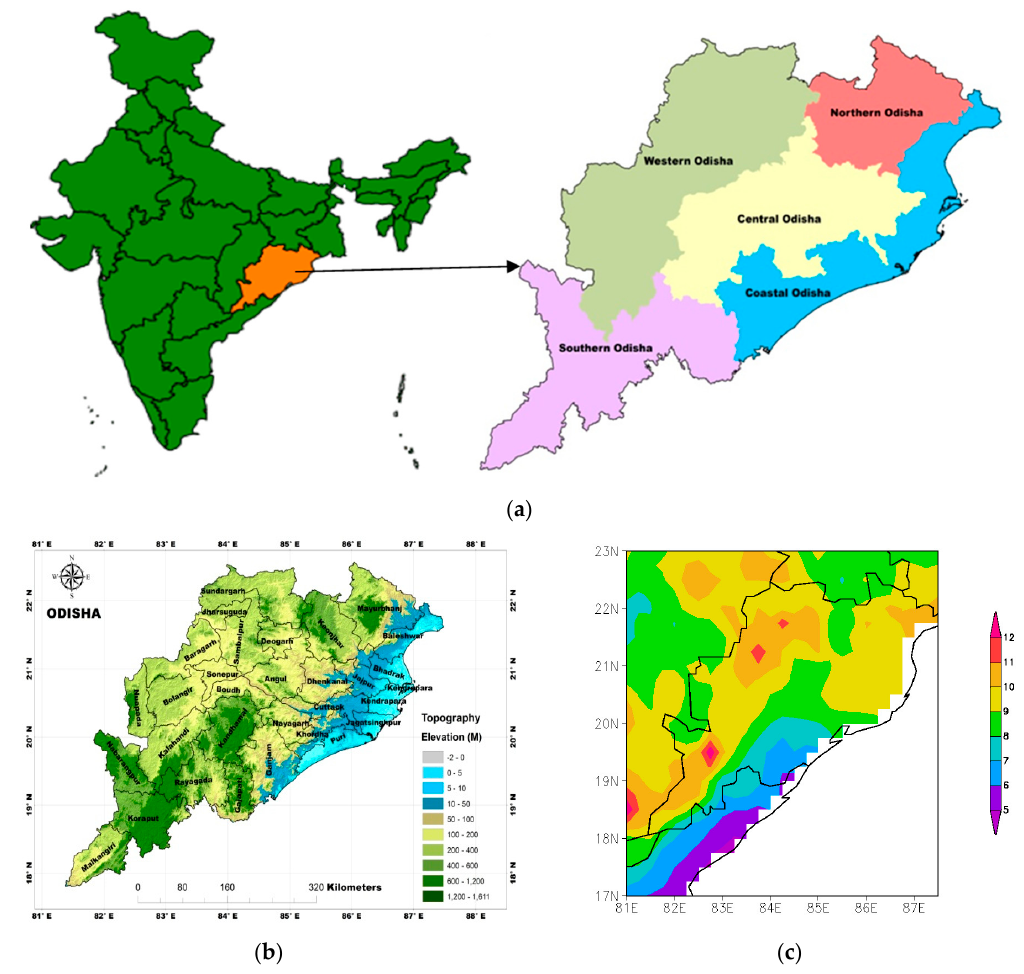
Figure 1. ( a ) Location of the Odisha state in India and a map showing the zones considered for study in the state of Odisha ( b ) topographic map of the state showing the elevation in meters; and ( c ) monsoon rainfall climatology over Odisha.